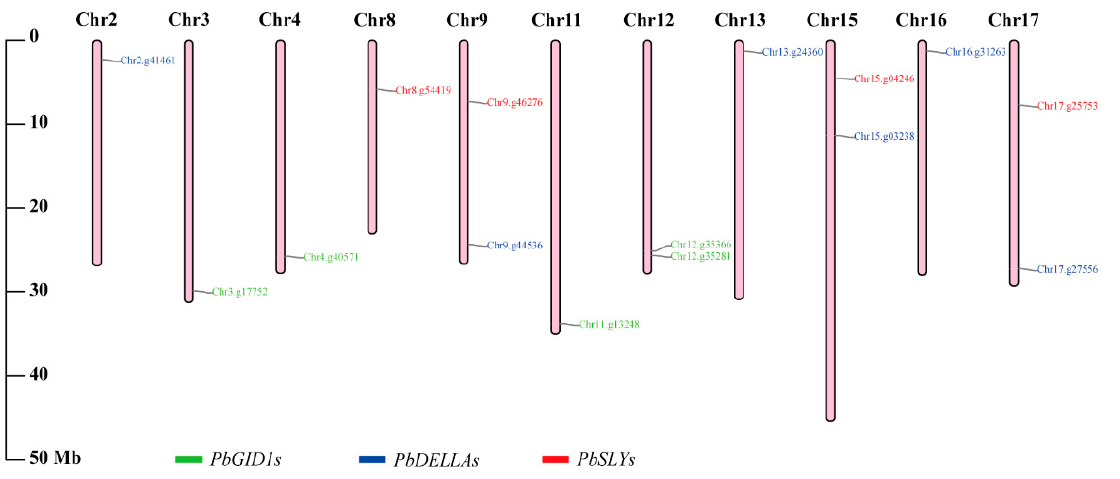
Figure 1. Chromosomal locations of PbGID1s , PbDELLAs , and PbSLYs . Pink vertical bars denote the chromosomes of ‘ duli ’ pear. The scale on the left indicates the chromosome lengths (Mb). The different families of GA signal genes are color-coded: PbGID1s , green; PbDELLAs , blue; PbSLYs , red.